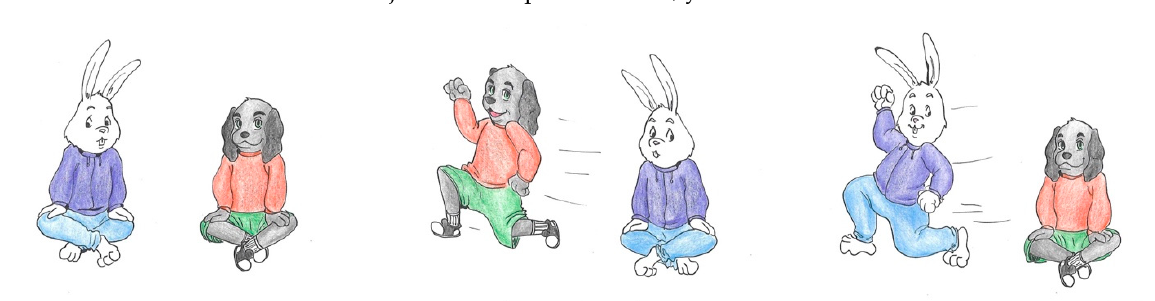
Figure A40. Filler stimulus 15. El perro manda al gato a pintar, y lo hace.